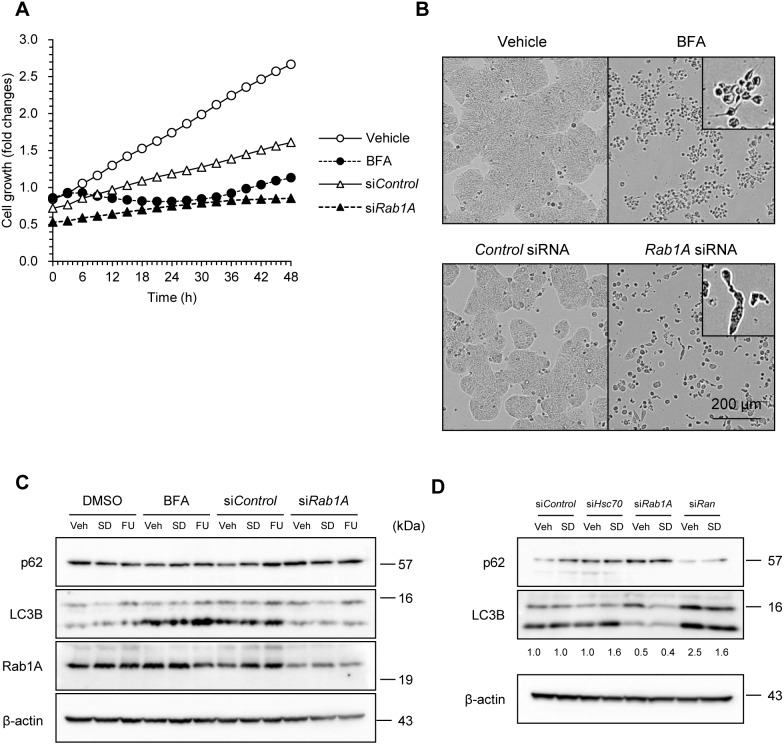
Rab1A-knockdown-induced cell death was caused by inhibition of autophagy but not ER-Golgi traffic.(A) BFA induced cell death differently from Rab1A knockdown. HT29 cells were transfected with Hsc70 or control siRNA and untransfected cells were treated with 5 µg/ml BFA or DMSO at the onset of IncuCyte cell growth assay. Images were captured to monitor proliferation by IncuCyte inside a cell culture incubator. (B) Phase-contrast images at 48 h after the onset of measurement. Scale bar, 200 µm. (C) Inhibition of autophagy was not caused by the interruption of ER-Golgi traffic. Rab1A knockdown or control cells were subjected to serum depletion, 5-FU, or vehicle treatment for 24 h. Untransfected cells were treated with 5 µg/mL BFA for 6 h, and immunoblotted with anti-p62, LC3B, or Rab1A. β-actin was used as a loading control. (D) Hsc70 knockdown allowed autophagosome formation. HT29 cells transfected with Hsc70, Rab1A, Ran, or control siRNA were subjected to serum depletion or vehicle treatment for 24 h, and immunoblotted. Immunoblotting data are representative of at least two separate experiments yielding similar results.